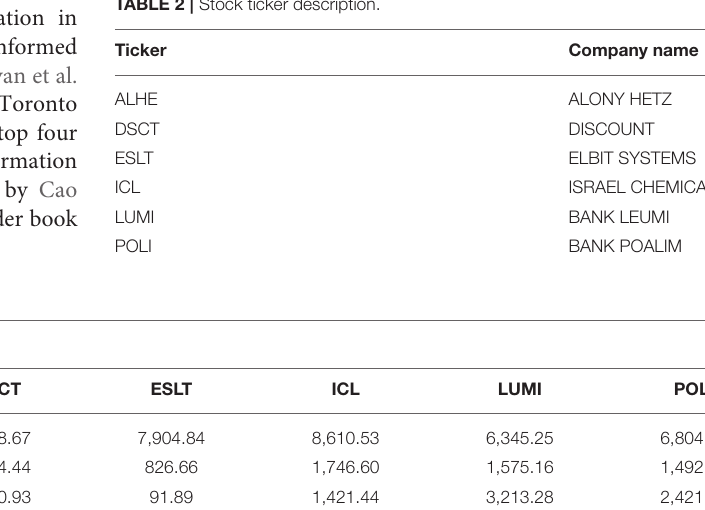
TABLE 2 | Stock ticker description.